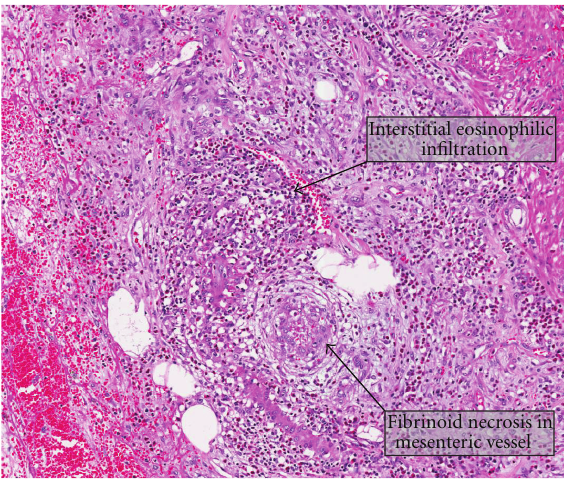
Figure 4: Eosinophilic colitis